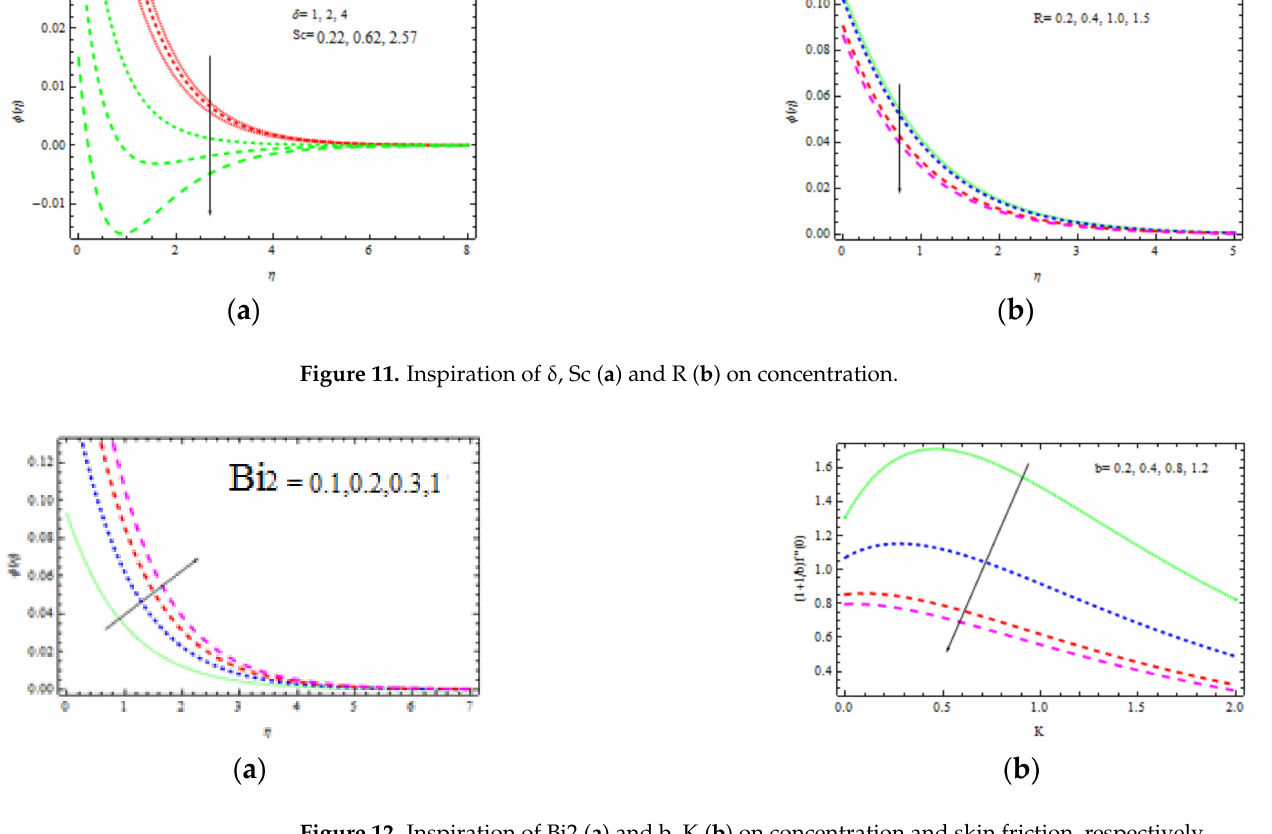
Figure 12. Inspiration of Bi2 ( a ) and b, K ( b ) on concentration and skin friction,